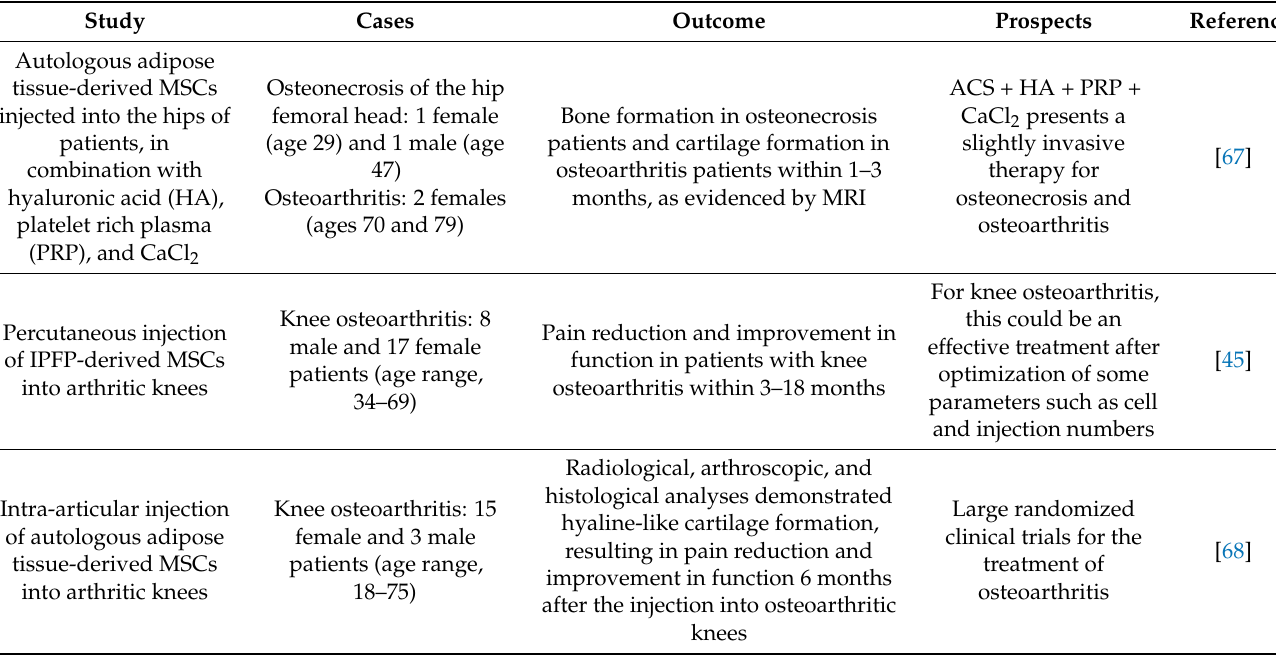
Table 5. Clinical studies on the use of MSCs for articular cartilage